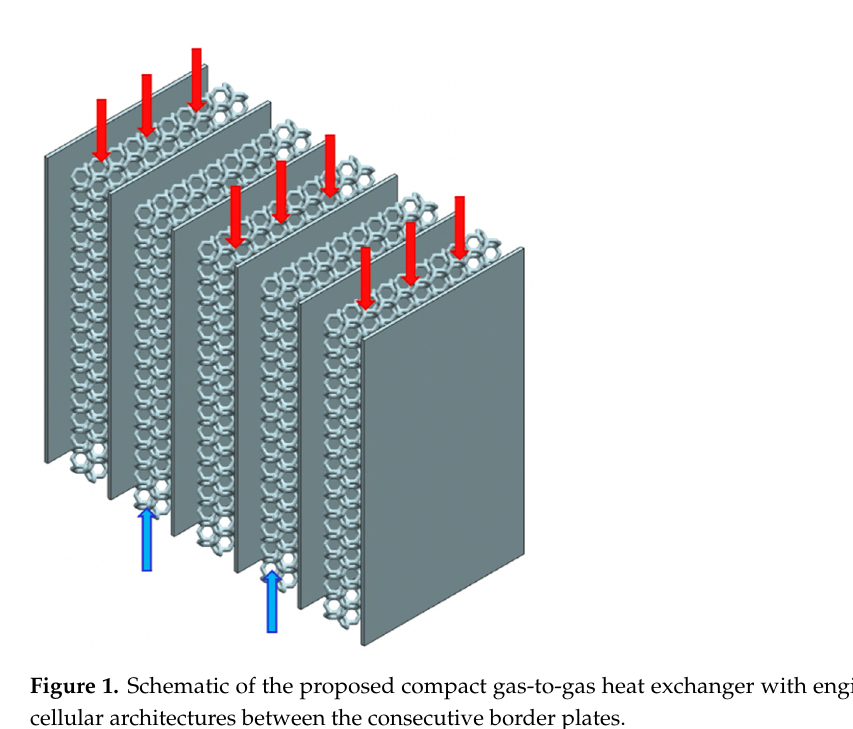
Table 1. Heat exchangers operating conditions of the HYDROSOL-beyond project.